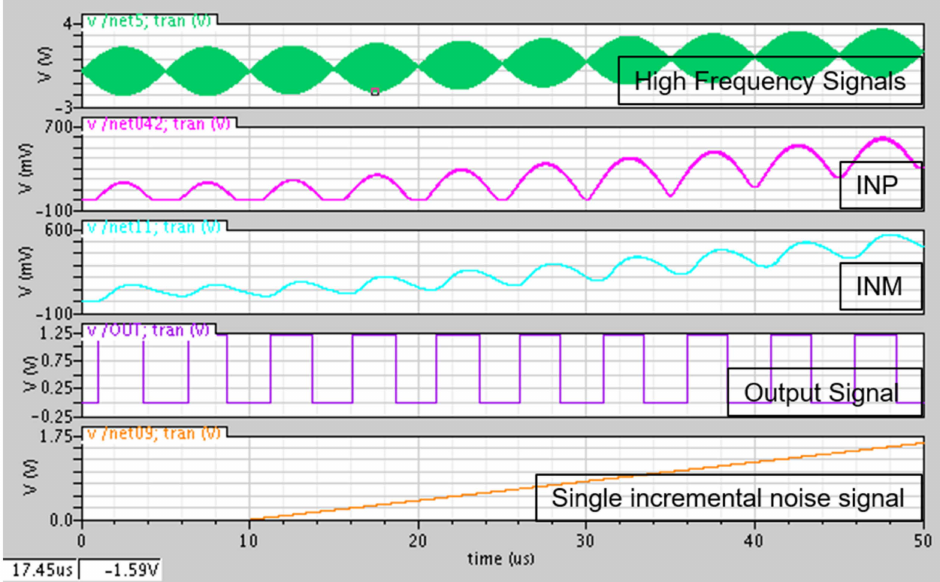
Figure 12. Verification of demodulation simulation correctness.